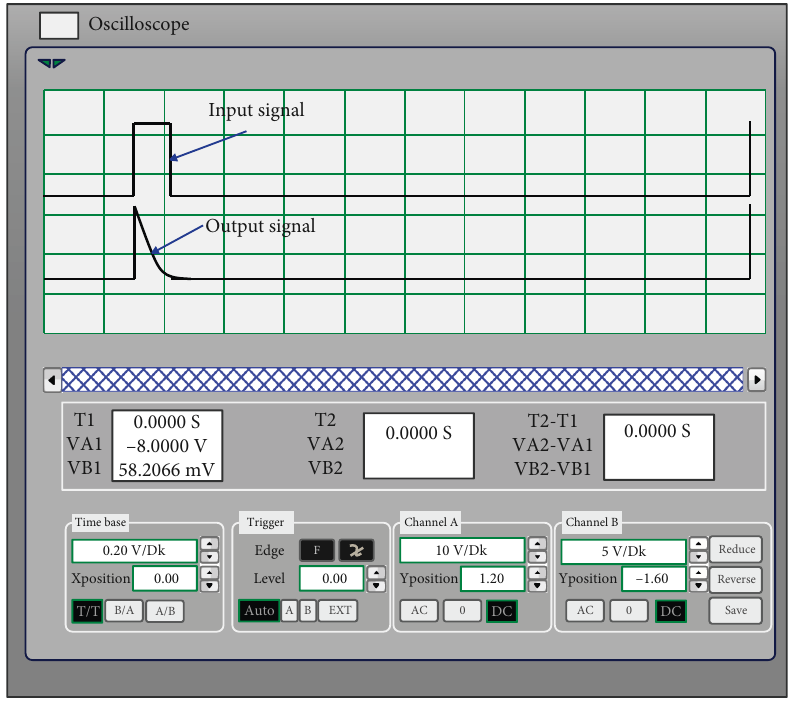
Figure 2: Simulation results of negative exponential signals at C